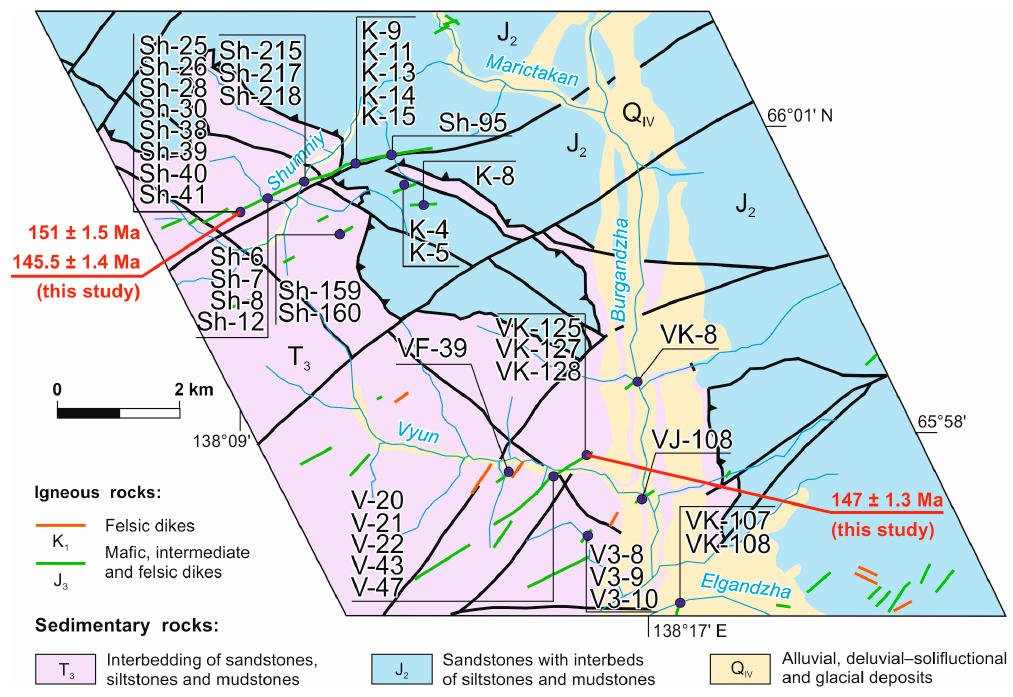
Figure 2. Geology of the region of the Vyun and Shumniy creeks, sampling sites locations and new U–Pb ages. The approximate location of the area is shown on Figure 1.